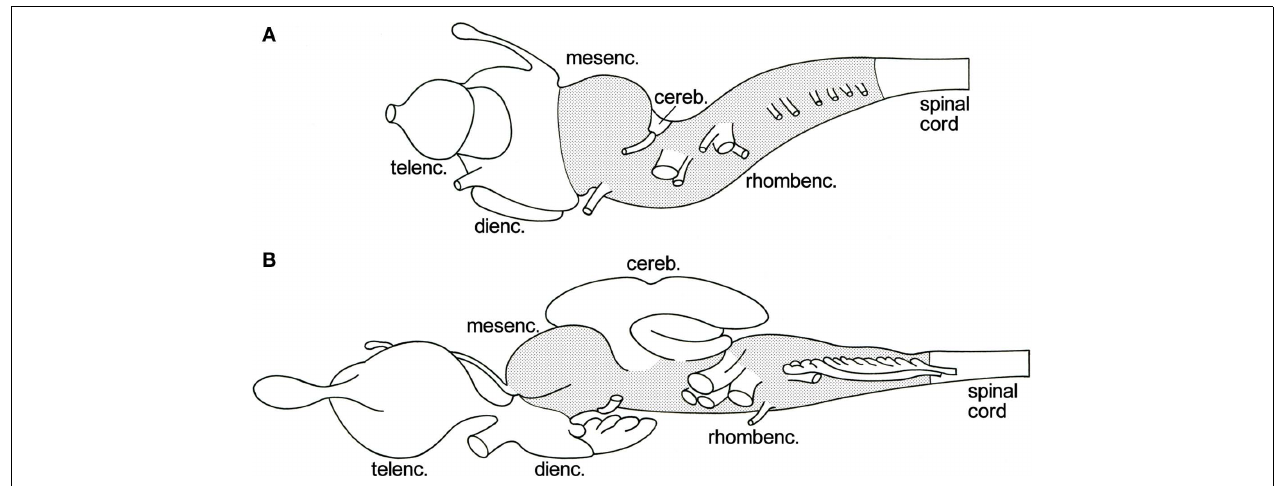
FIGURE 1 | Lateral views of the brains of the lamprey Lampetra fluviatilis (A), and the spiny dogfish Squalus acanthias (B). The brainstem, i.e., the mesencephalon plus the rhombencephalon minus the cerebellum, is stippled.